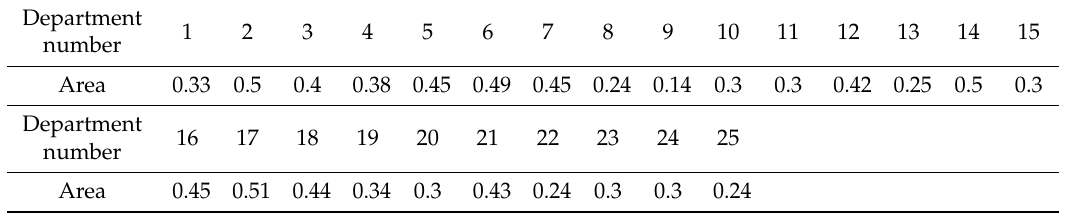
Table A2. The department area of